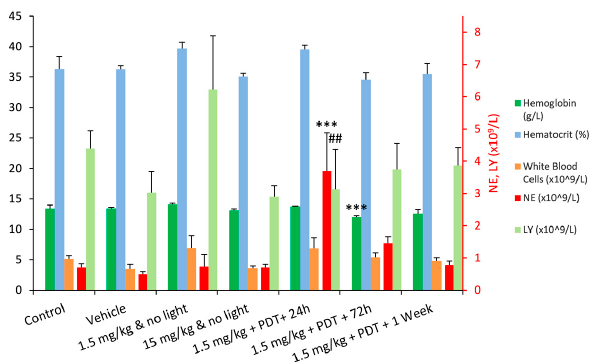
Figure 2. Summary of the most relevant results from Wistar rats haematology, presented as average ± SD. The values for the neutrophils (NE) and lymphocytes (LY) populations are presented in the secondary vertical axis. (*** difference relative to the control group— p <0.001; ## difference relative to the 1.5 mg/kg group— p < 0.01).